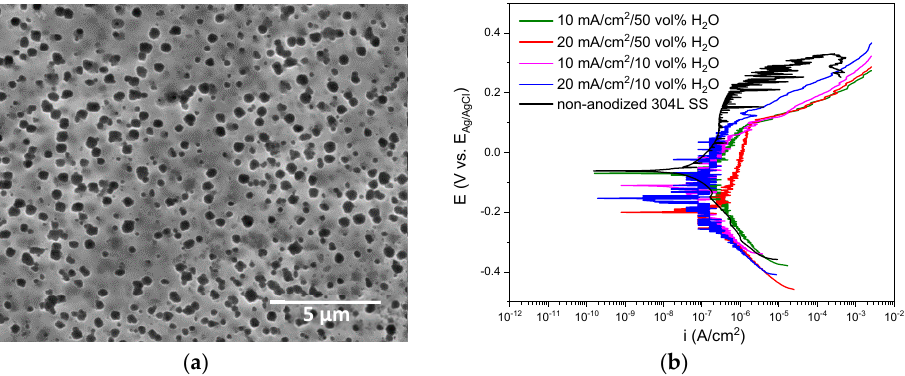
Figure 3. ( a ) SEM image of the anodic layer grown in a glycerol, 0.3 M NaAlO 2 and 10 vol% H 2 O for 30 min at 20 mA/cm 2 . ( b ) Potentiodynamic polarization curves for anodic layers grown in glycerol electrolyte containing 0.3 M NaAlO 2